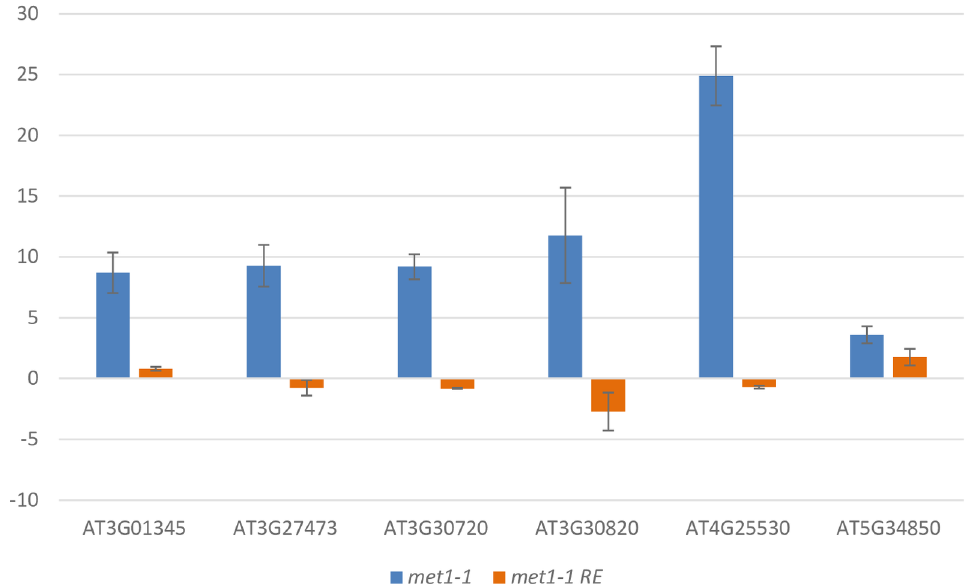
Fig 6. Comparison of expression profiles of genes AT3G01345 , AT3G27473 , AT3G30720 , AT3G30820 , AT4G25530 and AT5G34850 in the met1-1 mutant and met1-1RE . The mean and the standard error are shown for three biological replicates each tested in three technical replicates. Values on the y-axis represent the fold-difference compared to the control line.